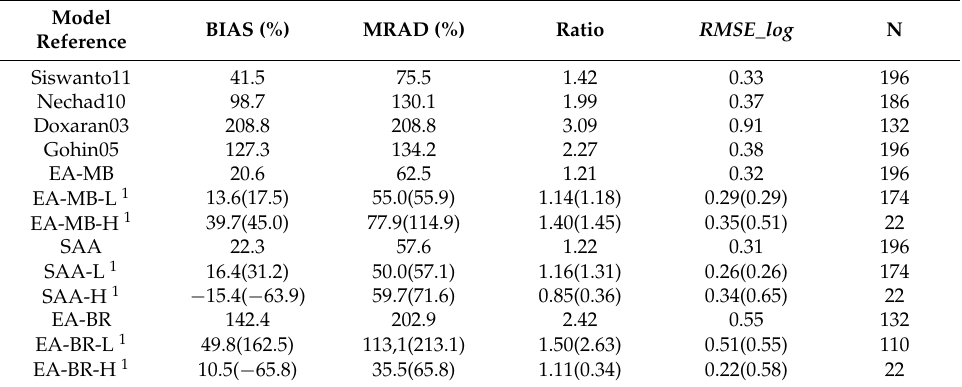
Figure 7. Comparison of the measured and inversed SPM values when the ( a ) EA-BR ; ( b ) SAA ; and ( c ) EA-MB models are applied to the DS-V in situ data set. Solid lines represent 1:1 line and dashed lines represent 1.5:1, 1:1.5 lines. The corresponding statistics indicators values are illustrated in each panel. Table 4. Statistics of original (Equations (9)–(12)) and re-tuned models (Table 3 computed based on the validation sub-dataset